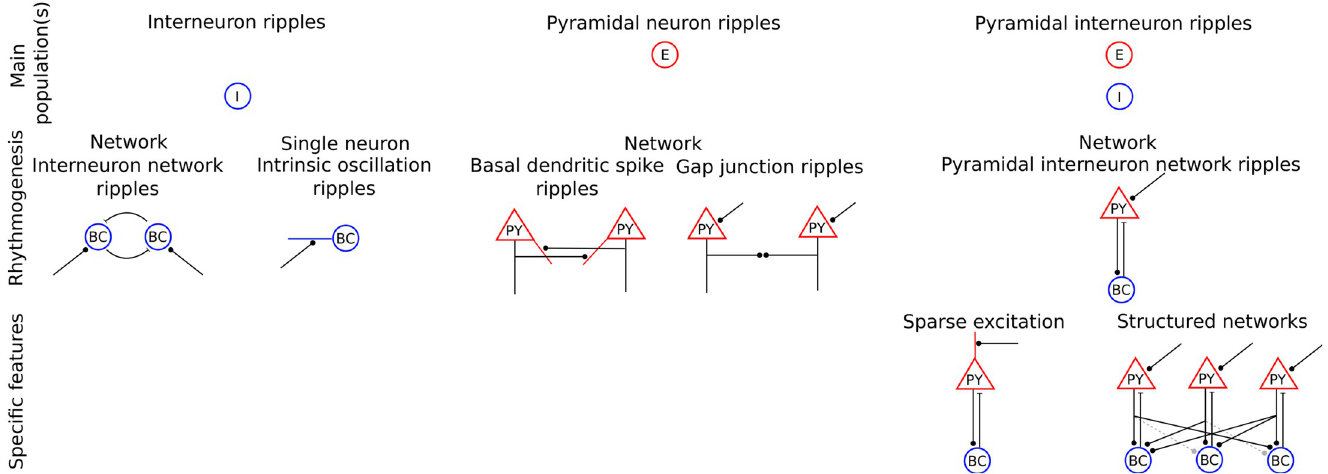
Fig 11. Our work in the context of previous CA1 ripple models. Visual depiction of our classification scheme of CA1 ripple models (see Introduction) with our models sorted in. The classification scheme has three levels, indicating (i) which neuron population or populations are mainly involved in the ripple generation, (ii) what the main mechanism for rhythmogenesis is (in particular if it is a network or single neuron mechanism) and (iii) specific features that are important for the overall rhythm. In the current article we have proposed new models (bottom right) of the class of pyramidal interneuron network ripples incorporating the specific features of sparse excitation (left) and structured networks (right, missing connections leading to sequential replay are gray dashed). These explain sparse pyramidal neuron and dense interneuron spiking during SPW/Rs. For clarity, specific model features of previous models are omitted, such as required structured networks for SPW/R generation in some basal dendritic spike models [42] and ripple generation by multiple disparate, inhibitorily coupled oscillators [36]. For our models one could have added further specific features such as recurrent inhibition. PY: pyramidal neurons, BC: PV+BCs.